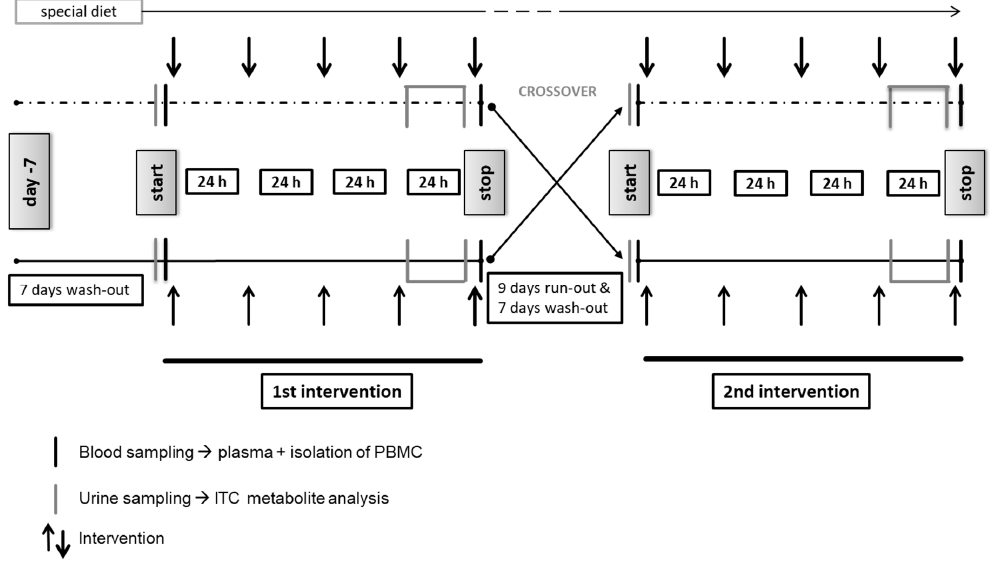
Figure 2. Study design of the randomized controlled cross-over intervention trial with B. carinata .